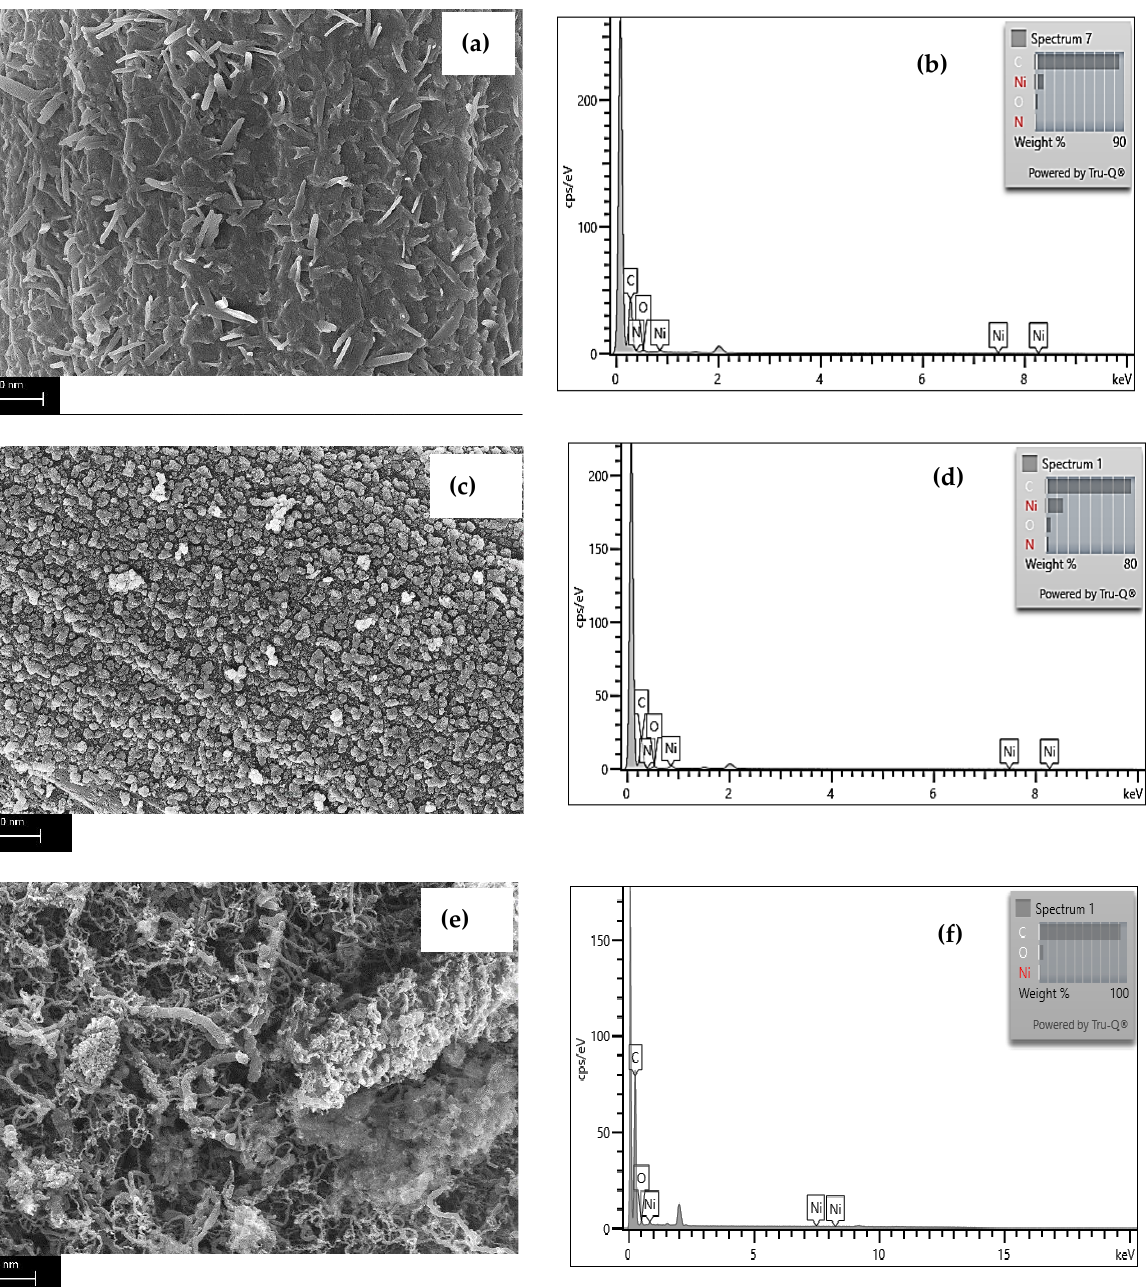
Figure 2. EDS of C and Ni elemental analysis for ( a , b ) carbon fiber with MOFs, ( c , d ) fibers with MOFs after reduction in a furnace under an inert environment, and ( e , f ) carbon fiber/CNTs reinforcement. The scale bar is 1 micron.